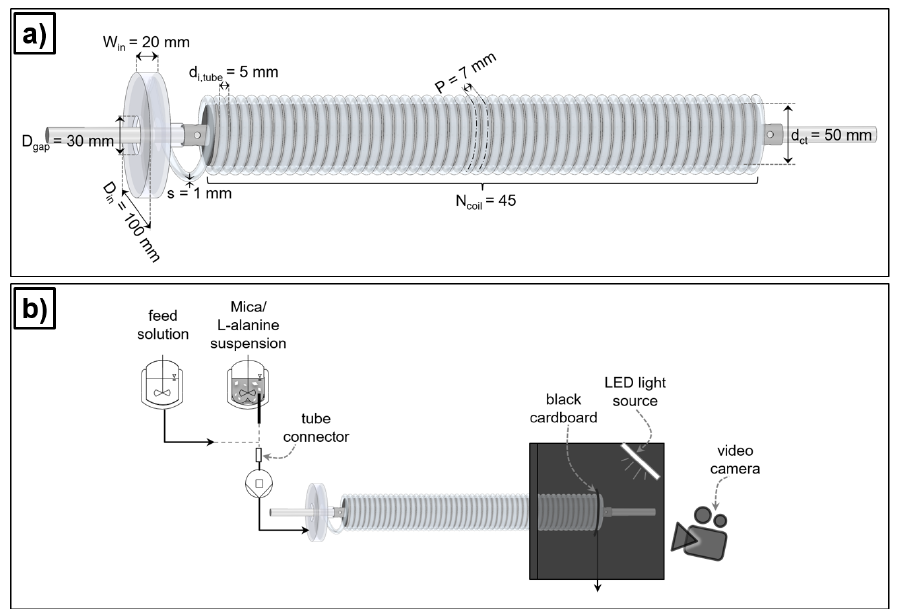
Figure 3. Schematic depiction of the ( a ) ATC dimensions (coiled tube length: 315 mm) and ( b ) experimental setup for validation experiments. For a more detailed description of experimental set-up and procedure, compare methods for solid-phase residence time distribution experiments by Sonnenschein and Wohlgemuth